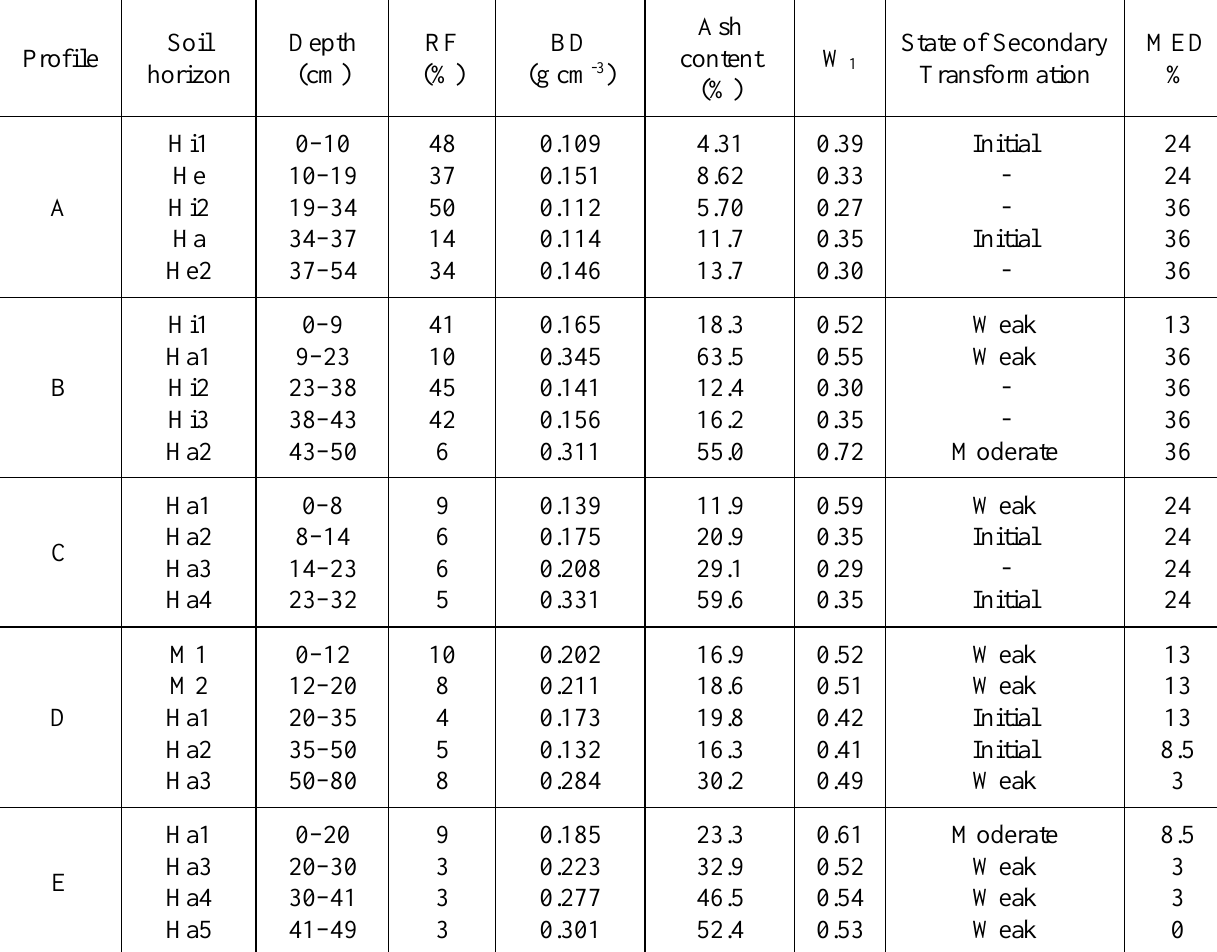
Table 3. Physical properties of the soil horizons in Profiles A–E (mean values from three replicates, n = 69).